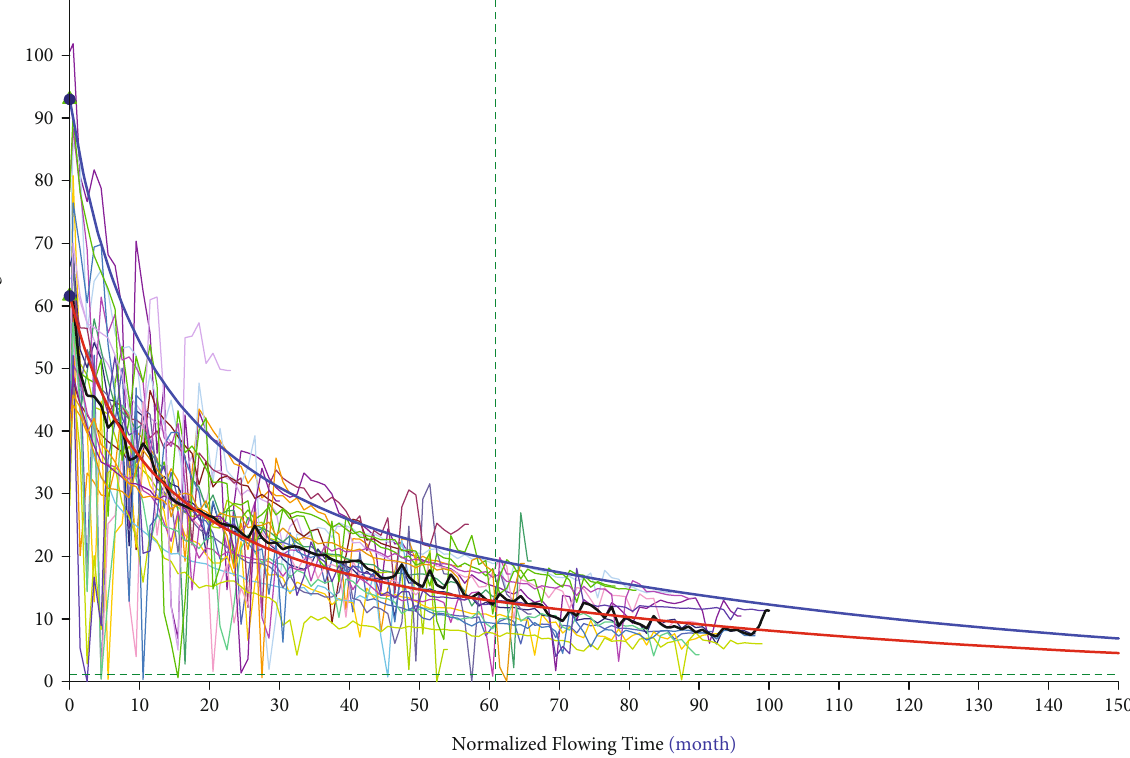
Figure 8: Prediction of the gas rate per meter in the upper layer in the S block. The bold black curve is the average unit lateral length obtained using the original drilling and completion technique, the bold red curve is the type well of the unit lateral length obtained using the original drilling and completion technique, the bold blue curve is the type well of the unit lateral length obtained using the designed drilling and completion technique, the horizontal green dashed line indicates the economic limit production per unit lateral length, and the vertical green dashed line indicates the boundary point between hyperbolic decline and exponential